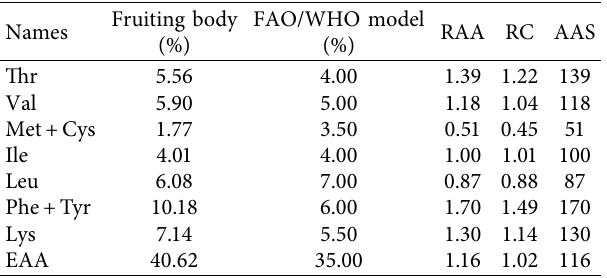
Table 3: Analysis of essential amino acid composition in hydro- lyzed amino acids in C. militaris .